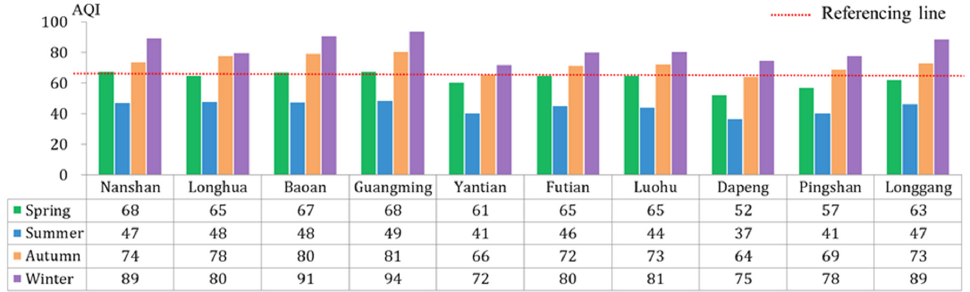
Figure 8. Seasonal average AQI in Shenzhen districts from March 2013 to February 2014 (referencing line represents the averaged AQI value which is 66 during the study period in Shenzhen).